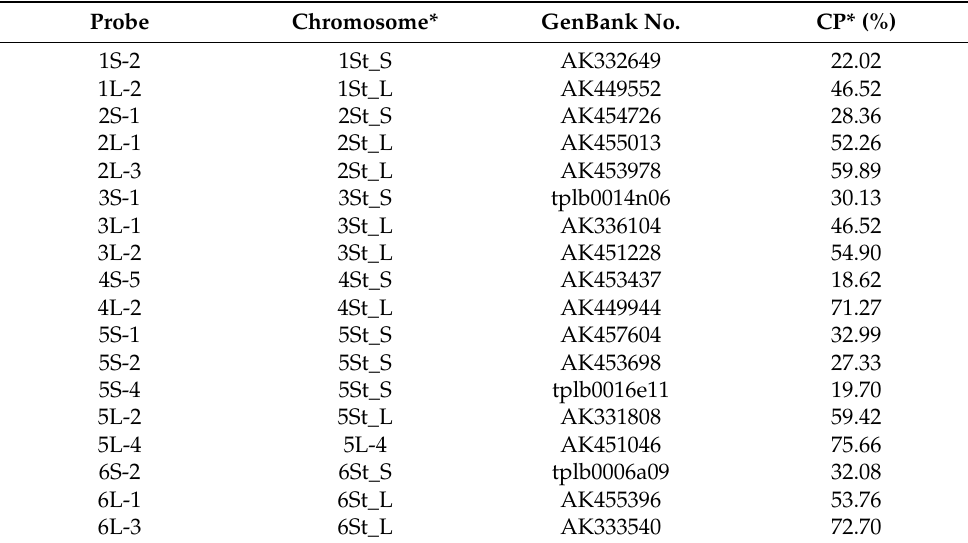
Table 1. Relative position of cDNA probes on P. libanotica chromosome.